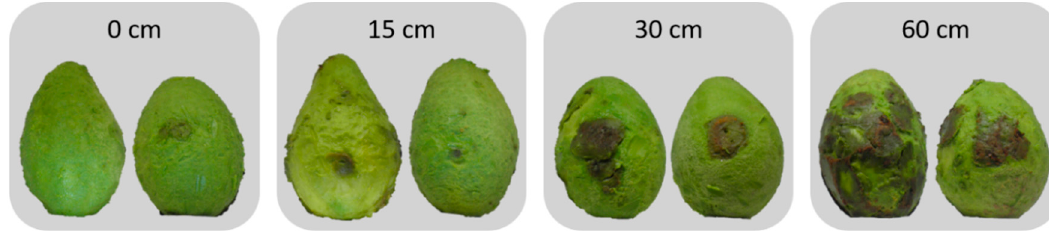
Figure 4. Body rot expression in 2017 season ‘Hass’ avocado fruit dropped 0, 15, 30 or 60 cm on the day of harvest in Experiment 5 and assessed at soft-ripe stage.